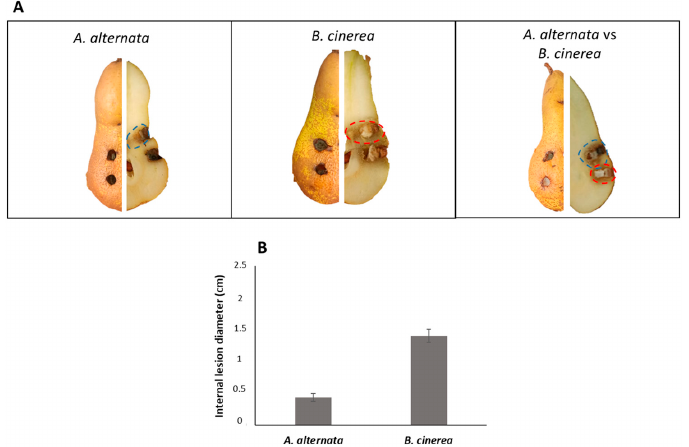
Figure 3. Pathogenicity assays on host Abate Fetel pear fruits. ( A ) Pathogenicity test on pear fruits; ( B ) severity (cm) of internal lesions on pear fruits.